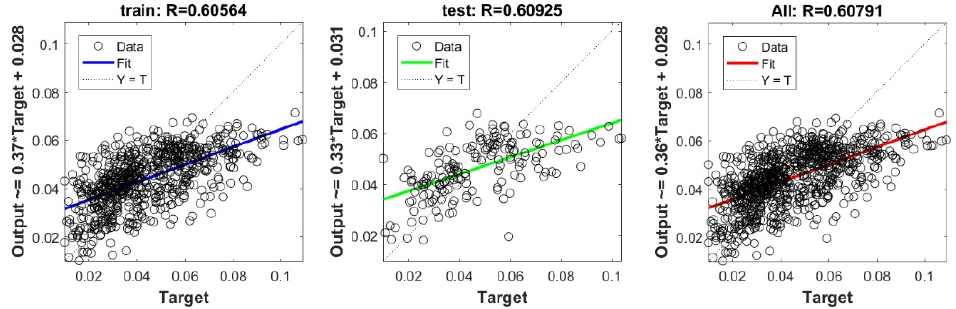
Figure A24. Scatter plots between target and output value by the PSO-KRidge model.